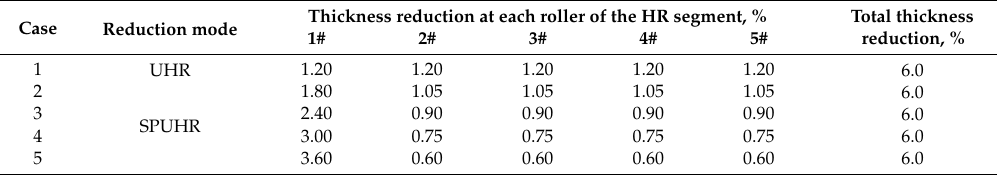
Table 3. HR deformation distribution within the HR segment in five